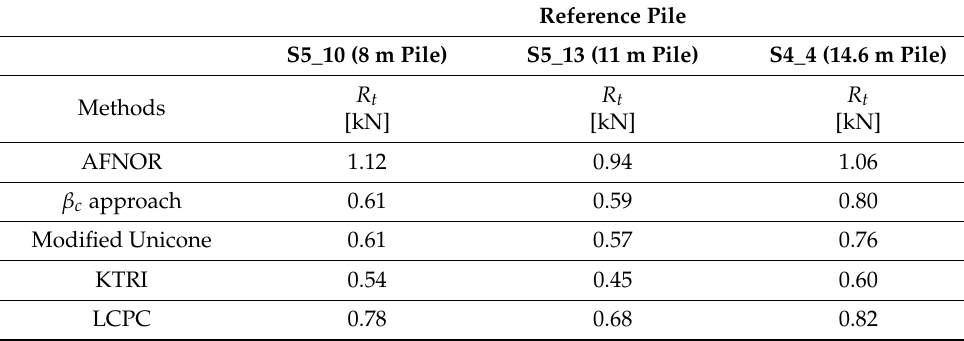
Table 2. Ratio between predicted and ultimate pile shaft capacity, R t